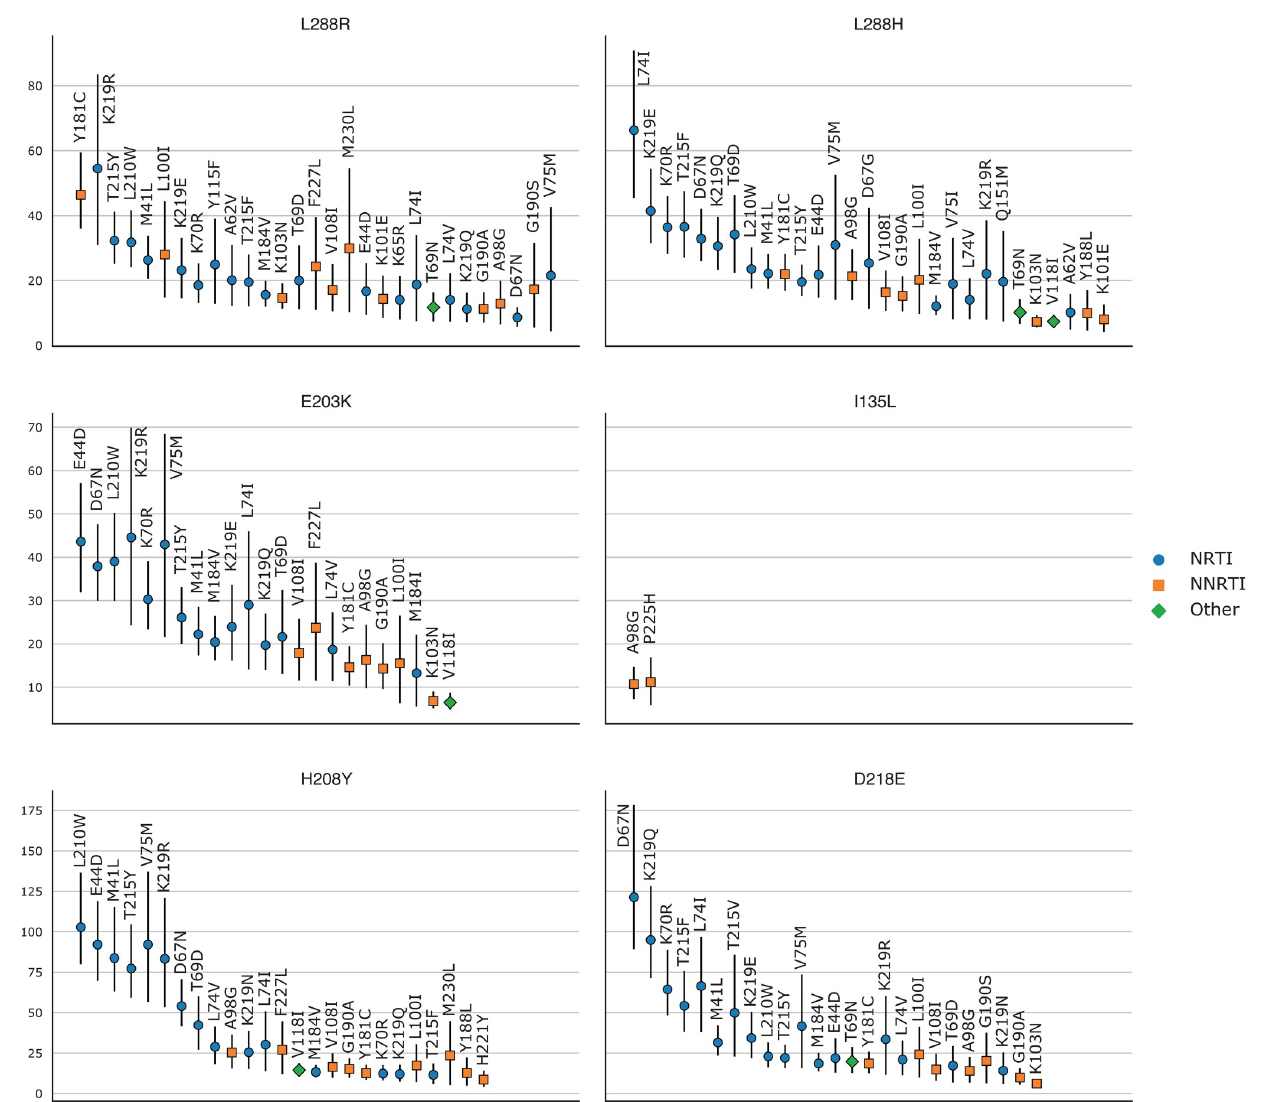
Fig 3. Relative risk of the new mutations with regards to known RAMs on the UK dataset. (i.e. the prevalence of the new mutation in sequences with a given known RAM divided by the prevalence of the new mutation in sequences without this RAM). RRs were only computed for mutations (new and RAMs) that appeared in at least 0.1% (=55) sequences. 95% confidence intervals, represented by vertical bars, were computed with 1000 bootstrap samples of UK sequences. Only RRs with a lower CI boundary greater than 4 are shown. The shape and color of the point represents the type of RAM as defined by Stanford’s HIVDB. Blue circle: NRTI, orange square: NNRTI, green diamond: Other. RR values are shown from left to right, by order of decreasing values on the lower bound of the 95% CI.